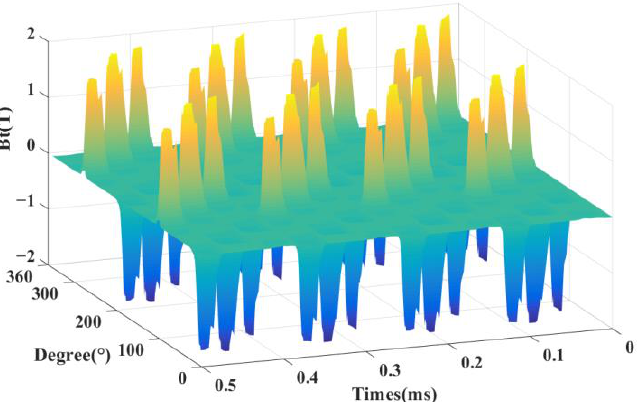
Figure 10. Radial magnetic density – rotor position – time waveform of external air gap of DDSRG.